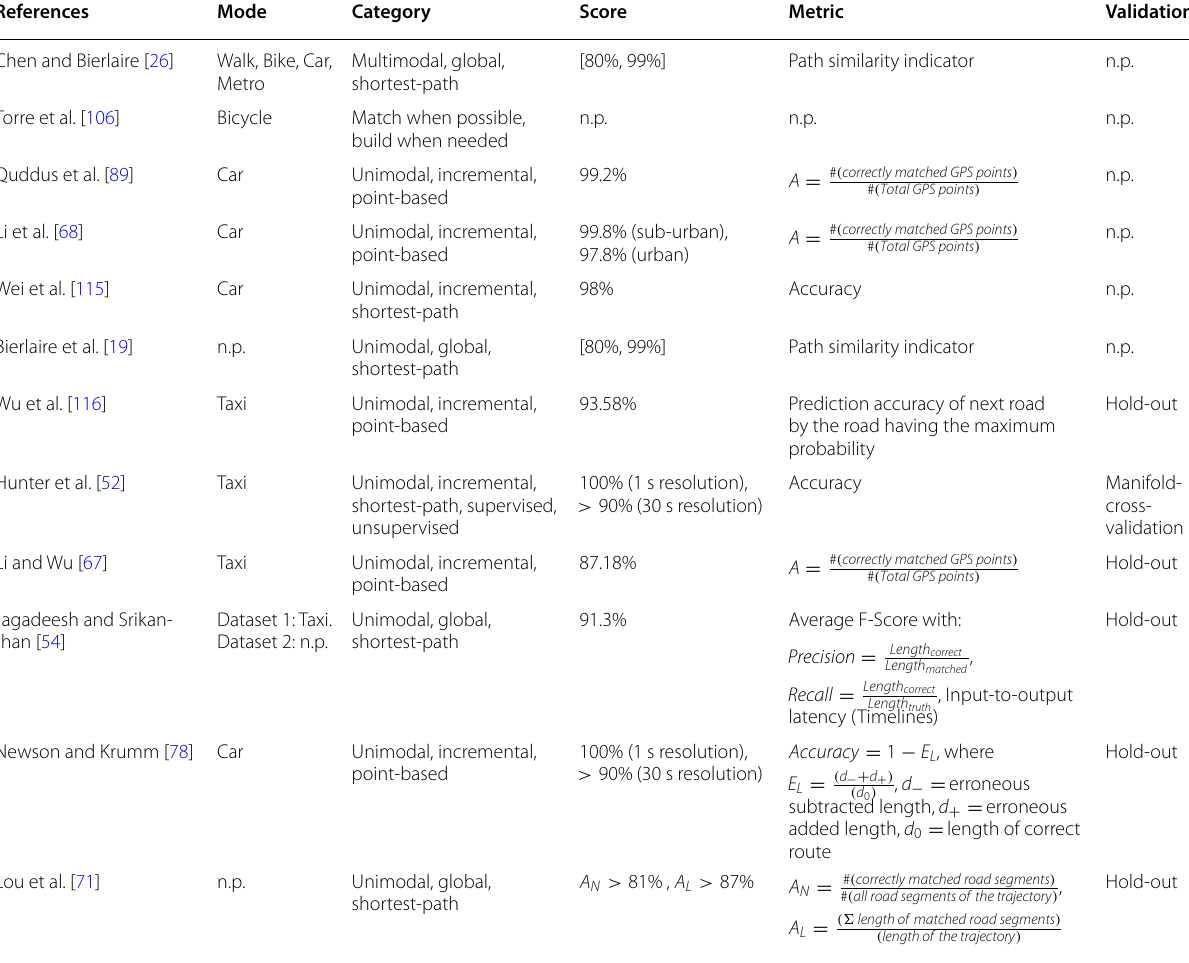
Table 7 Map-matching task ranked by difficulty and